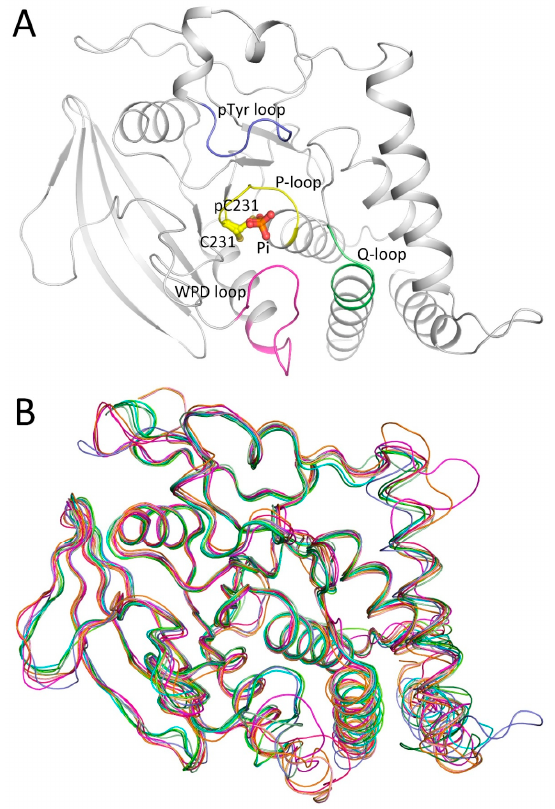
Figure 1. Structure of the protein tyrosine phosphatase non-receptor 12 (PTPN12) catalytic domain. ( A ) Overall structure of the PTPN12 catalytic domain. The PTPN12 catalytic domain, pTyr recognition loop, P-loop, tryptophan-proline-aspartate (WPD)loop, and Q-loop are colored grey, blue, yellow, magenta, and green, respectively. The free phosphate ion and two conformations of catalytic cysteine 231 (pC231 and C231) are shown in stick-ball models; ( B ) comparison of the structures of the protein tyrosine phosphatase (PTP) catalytic domain. Blue, PTPN12; light green, free PTPN18, PDB ID 2OC3; green , PTPN18 in complex with the human epidermal growth factor receptor 2 (HER2)pY1248 peptide, Protein Data Bank (PDB) ID 4GFU; dark green , PTPN18 with HER2 pY1196, PDB ID 4GFV; cyan , PTPN18 with HER2 pY1112, 4NND; pink , free PTPN22 catalytic domain, 2P6X; magenta , free PTPN22, 2QCJ; red , PTPN22 with inhibitor I-C11, 2QCT; orange , PTPN22 with phosphate, 3H2X; yellow , PTPN22 with inhibitor L75N04, 4J51. Figures were prepared